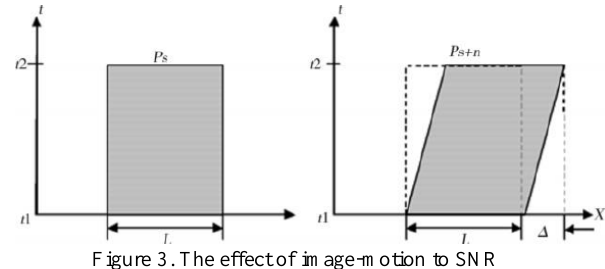
Figure 3. The effect of image-motion to SNR